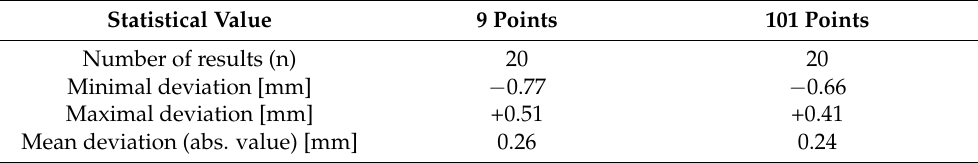
Table 7. Statistical values [mm] related to the analysis of the tester’s influence on the test result. Statistical